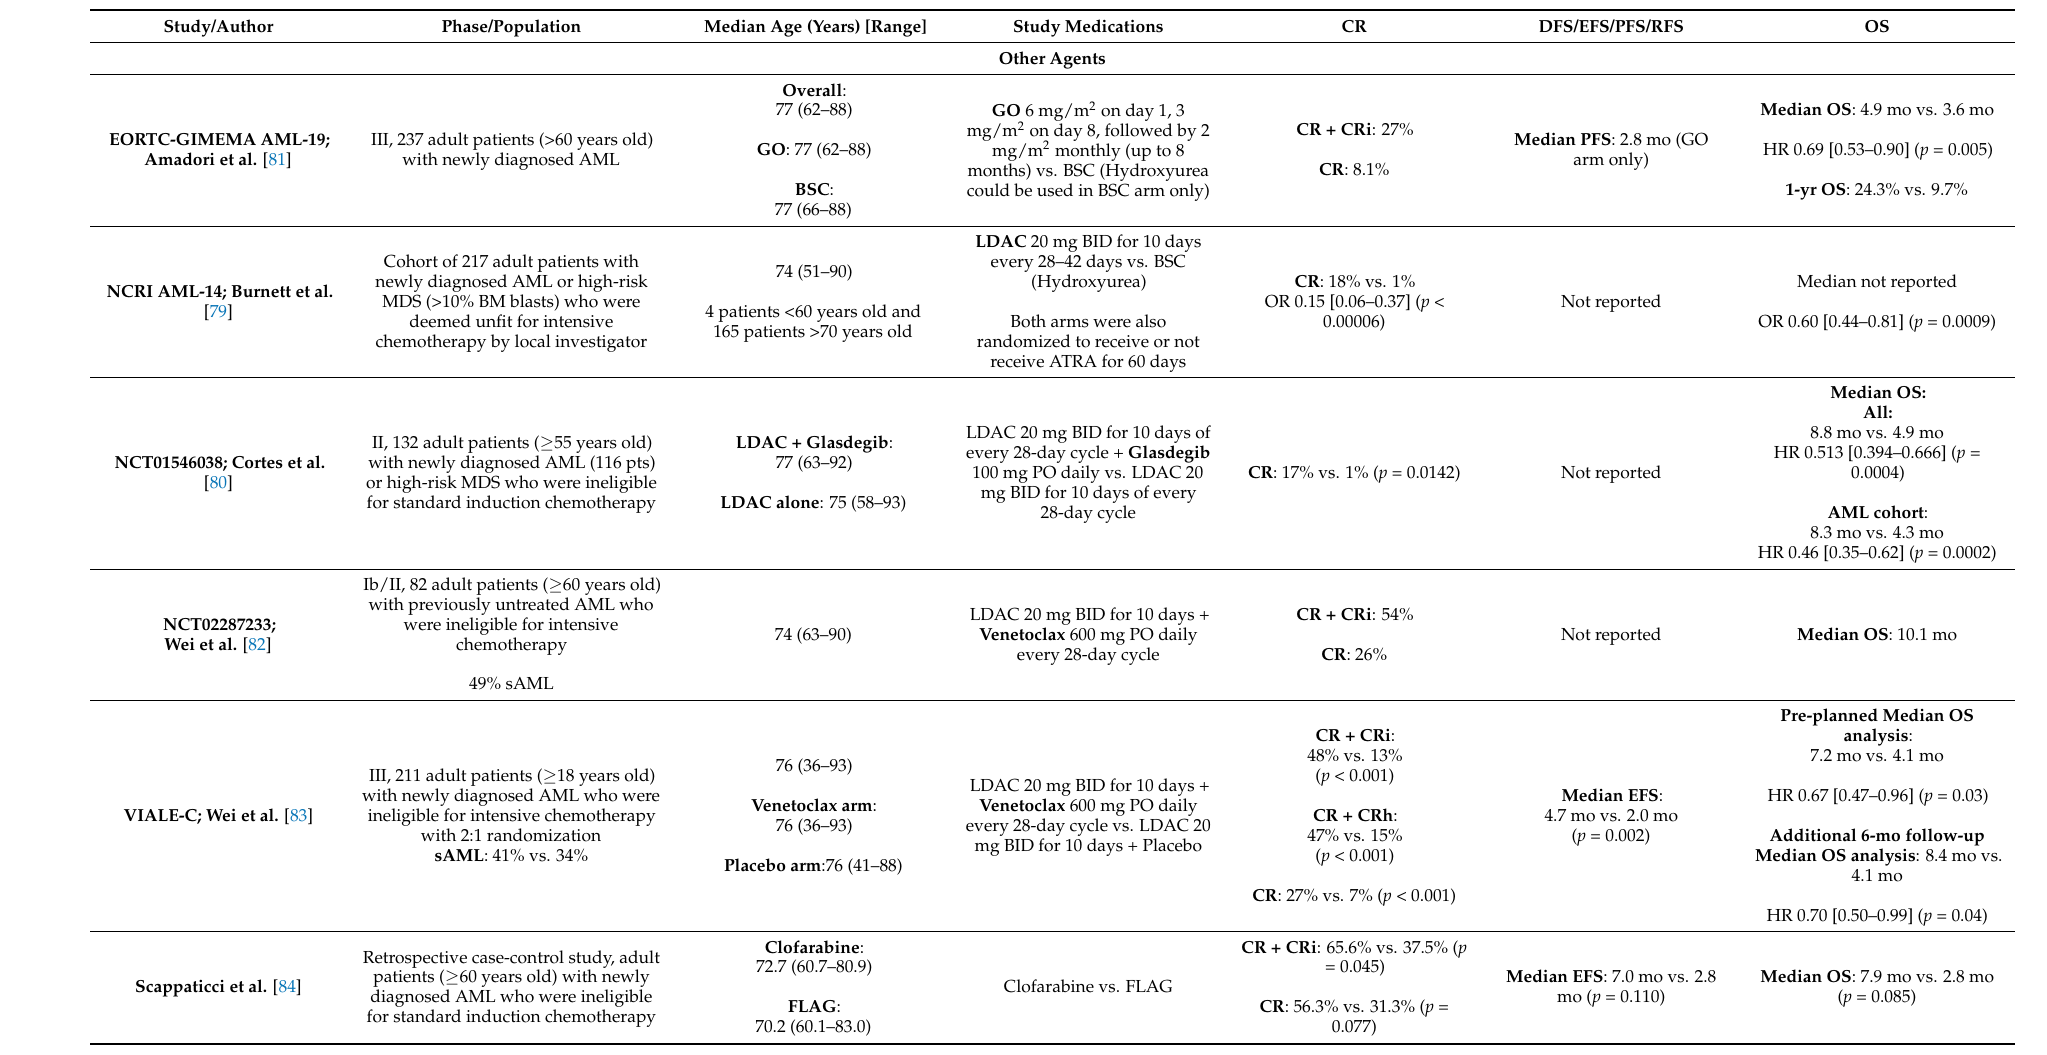
Table 3. Other non-intensive non-hypomethylator-based frontline regimens for patients with